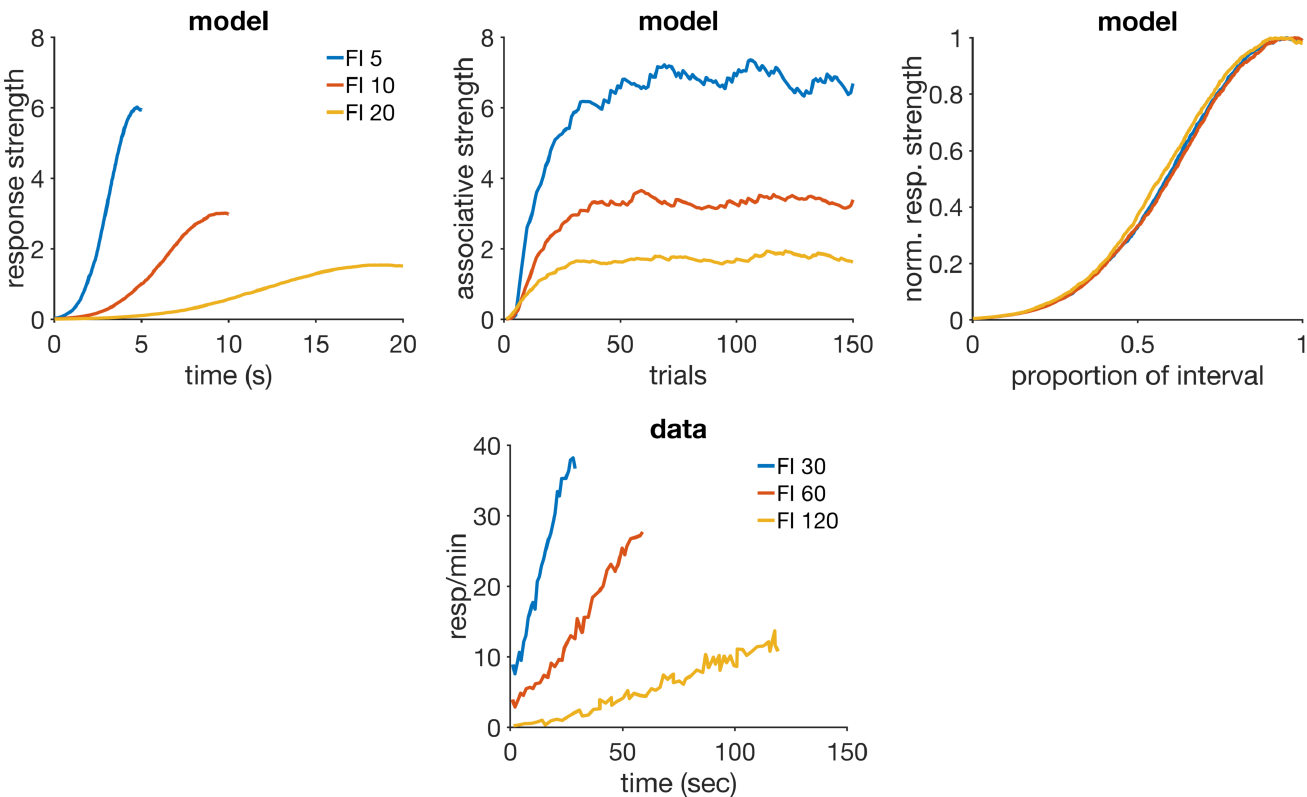
Fig 11. ISI effect. Top row: simulatedaverageresponserate duringCSs (left), associative strength over trials (middle), and superimpositionof response curves (right). Bottom row: averageresponserate data from an FI experiment, redrawnfrom bottom right panel of figure 4 in [102]. Model parameters: m = 0.15, θ = 1, σ = 0.3, α t = 0.2, α V = 0.1, H = 5.